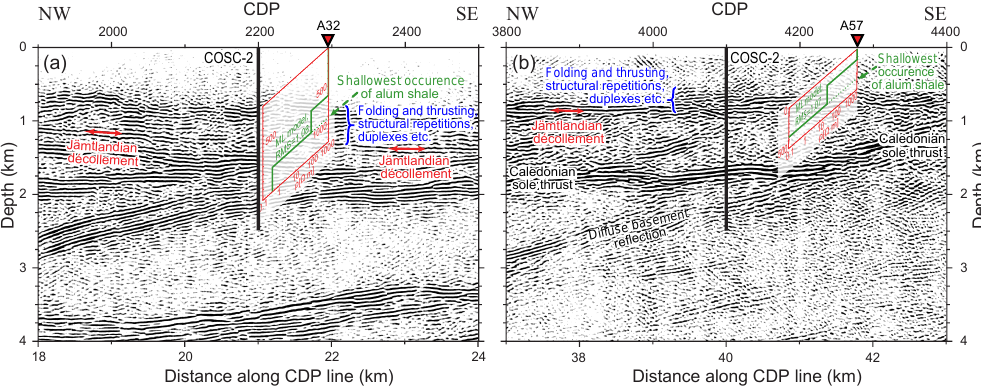
Figure 10. (a) Option 1 for the COSC-2 borehole. Here, the Jämtlandian décollement would be penetrated at about 1.3–1.5km depth, if the interpretation in Fig. 9b is correct. Logistically, it is easier to place the borehole about 1km to the east. Even at this location, two or three Precambrian reflectors would be penetrated. (b) In option 2 for the COSC-2 borehole, the Jämtlandian décollement would be drilled at about 500m depth. The structure beneath the Jämtlandian décollement, down to about 1600m, is dominated by a duplex, probably consisting of sedimentary formations and basement-derived imbricates. The basal thrust of the duplex is inferred to coincide with the Caledonian sole thrust. The conductivity profiles shown in the figures are placed at the locations of the MT stations that the inversions were performed for.